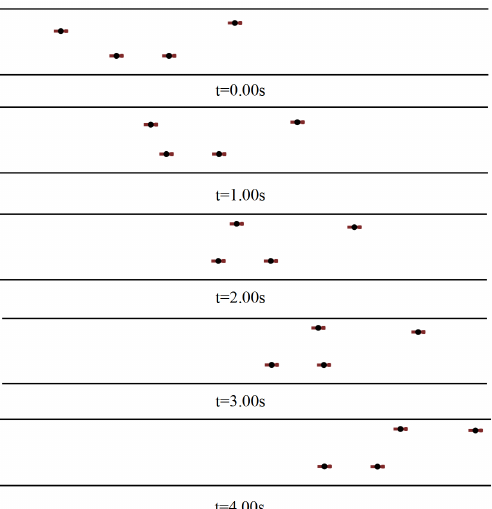
Figure 7. Simulation diagram of a bicycle following a bicycle at each moment.